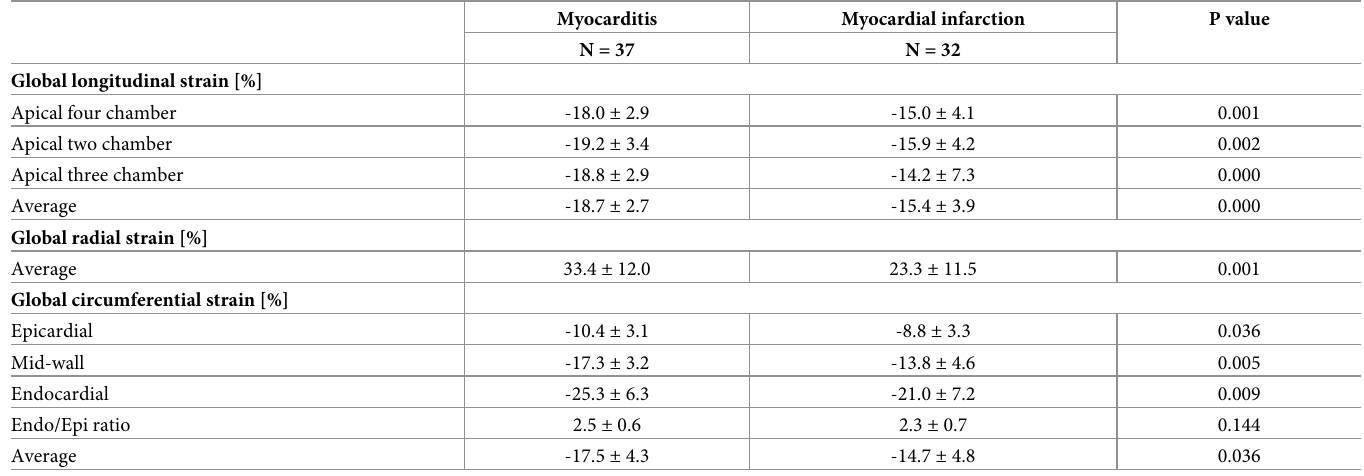
Table 3. STE data.